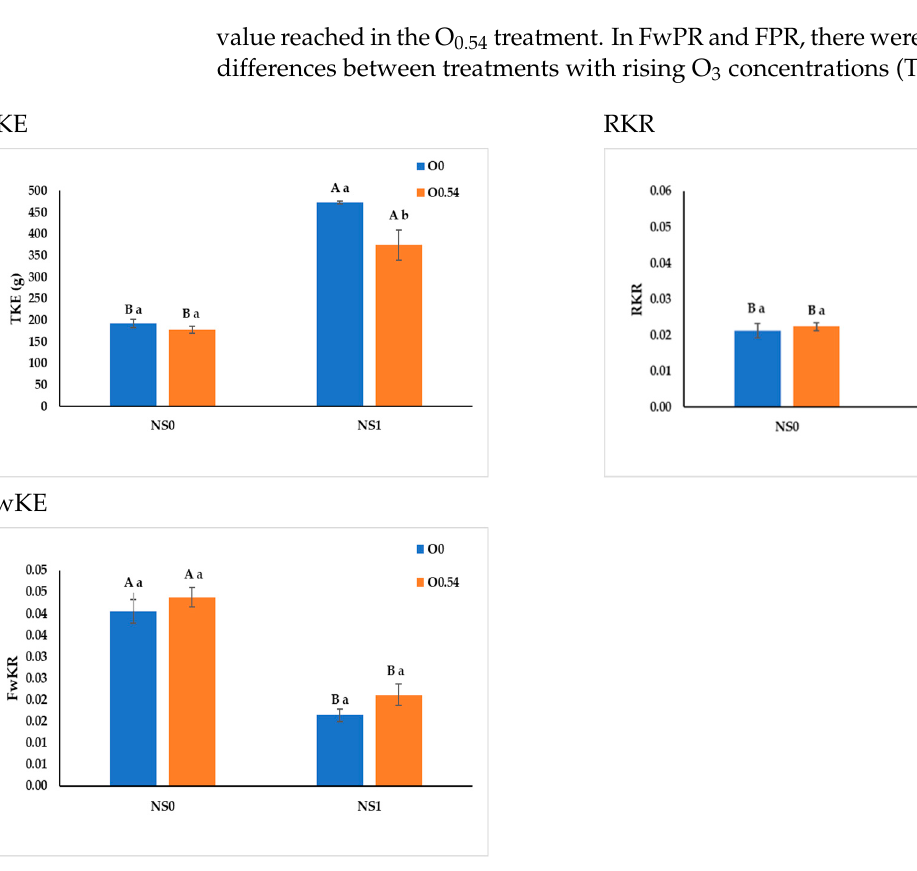
Figure 6. Interactions between fertigation treatments and ozone supply on total potassium extracted (TKE) from plants, RKR, and FwPR. The comparison between the ozone supplies is assessed with lowercase letters. Capital letters are used to analyze the comparability of fertigation treatments. Different letters denote significant treatment changes (LSD test, p < 0.05). Table 16. Effect of O 3 dosage on total potassium extracted by plant (TKE) (mg plant − 1 ) and their distribution in root (RKR), stem (SKR), leaf (LKR), flower (FwKR), and fruit (FKR) (dimensionless). The data recorded are the means ± standard deviation of four samples per treatment at the end of the experimental period. In each column, different letters denote statistically significant changes between treatments (LSD test; p < 0.05).